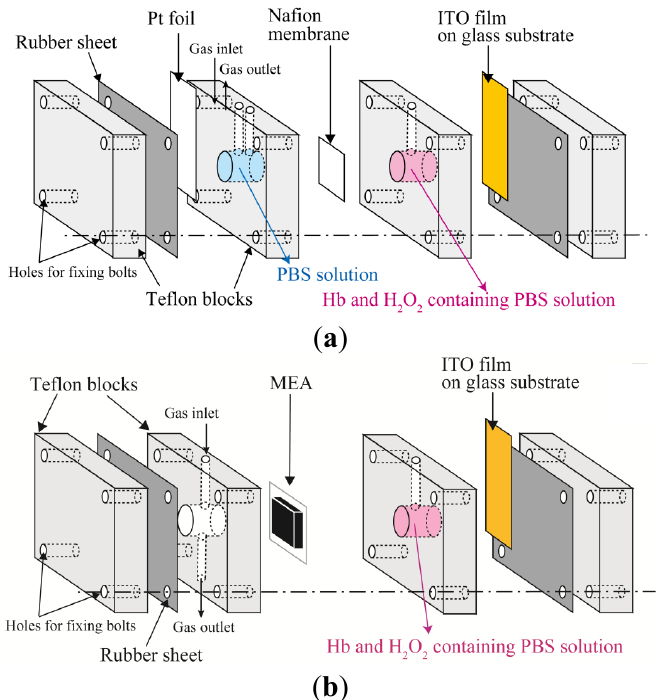
Figure 4. Illustration of single cell components: ( a ) single cell type I used in our previous work; ( b ) single cell type II and ( c ) single cell type III utilizing the anode composition of PEFCs examined in this study. ITO-coated glass plate and glass filter are used as the cathode in b and c ,